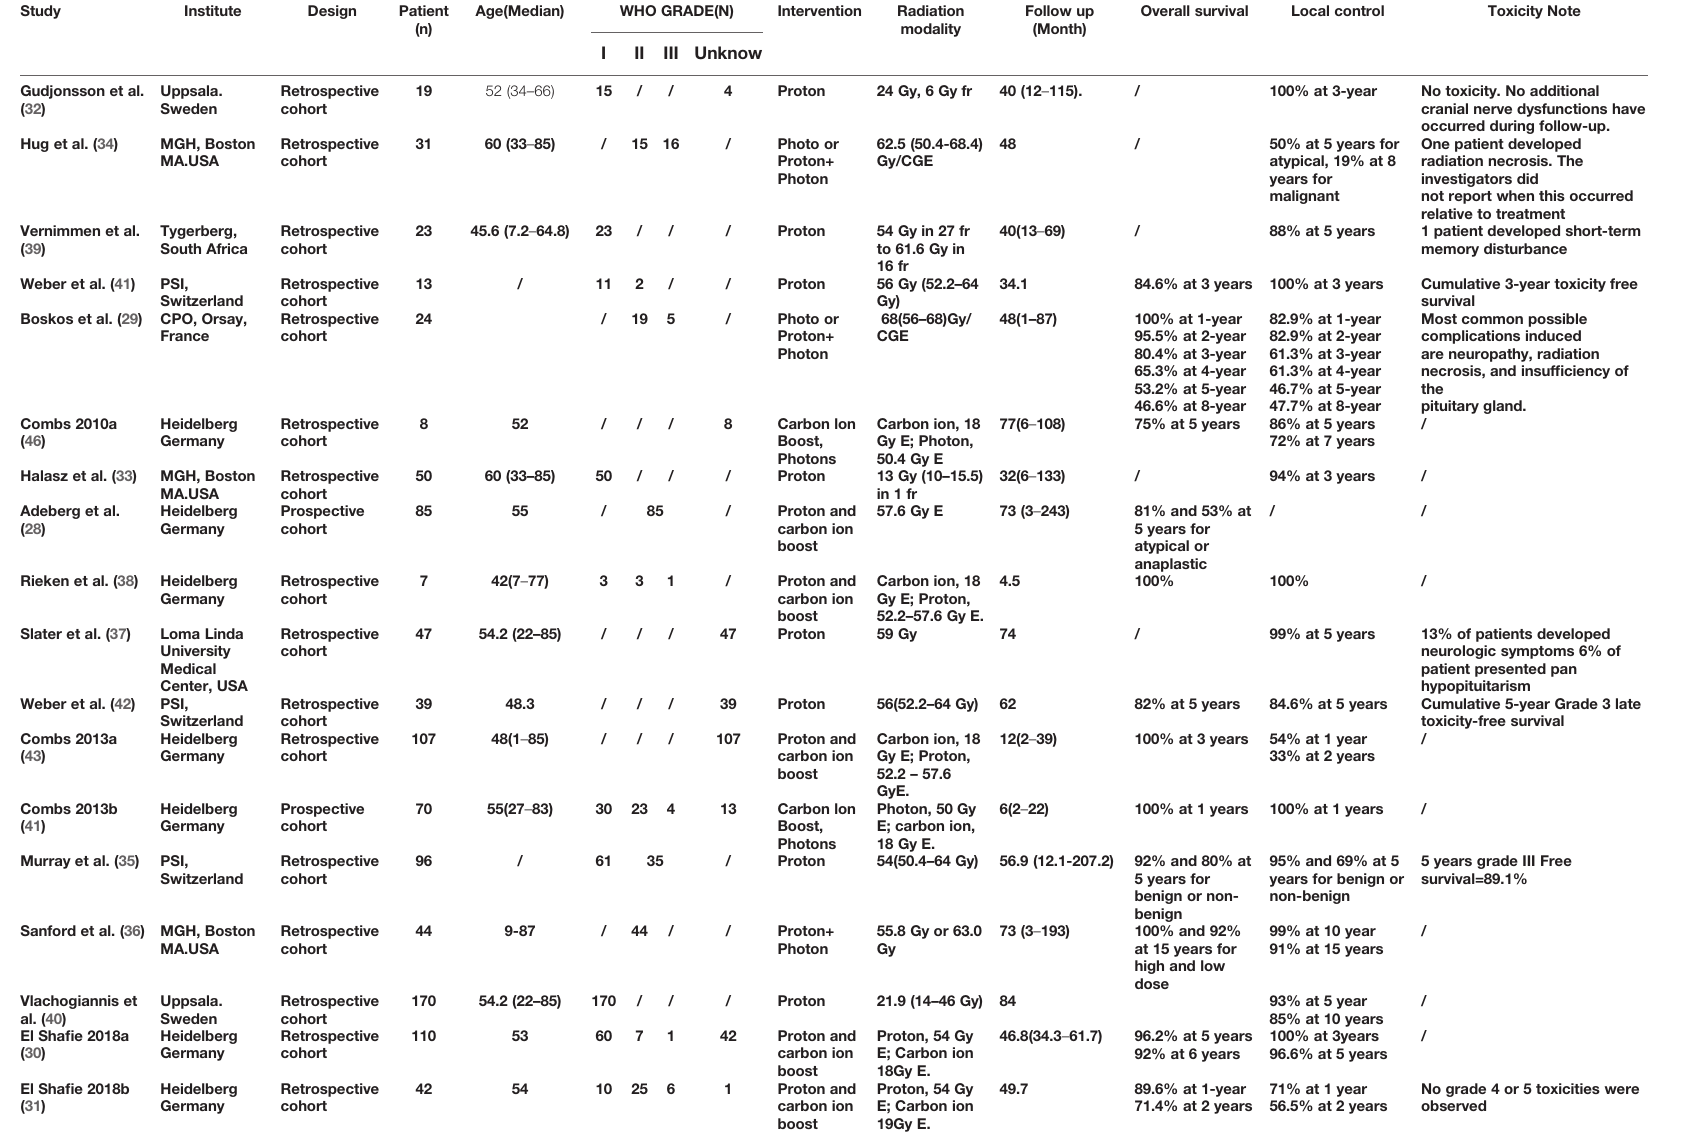
TABLE 1 | Characteristics of the